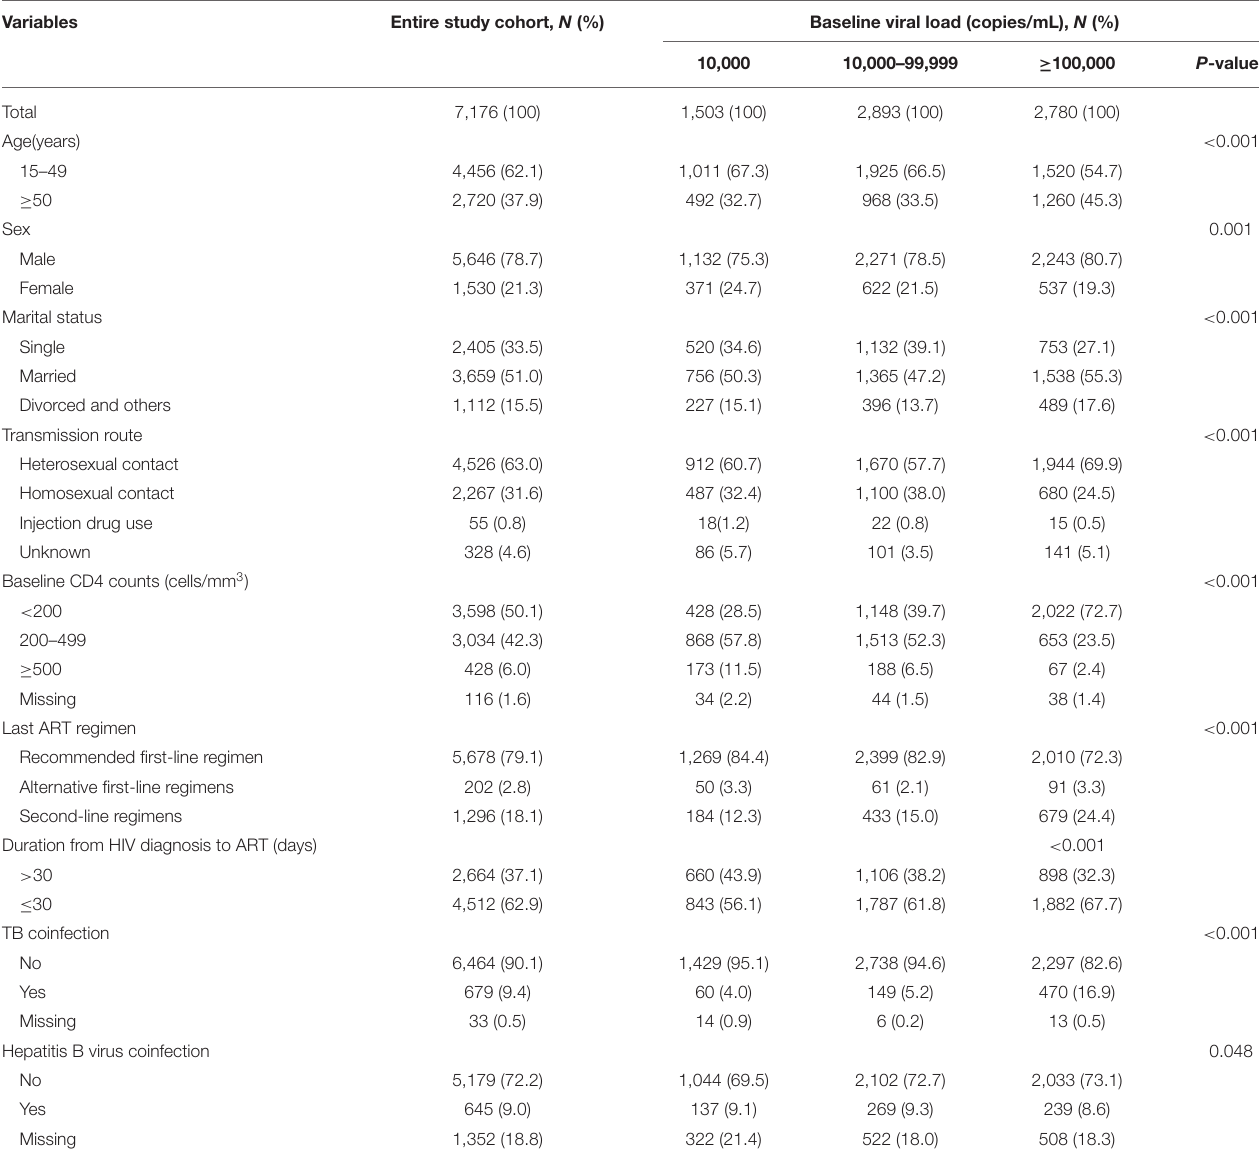
TABLE 1 | Characteristics of HIV patients initiating ART between 2015 and 2019 in Chongqing, China.